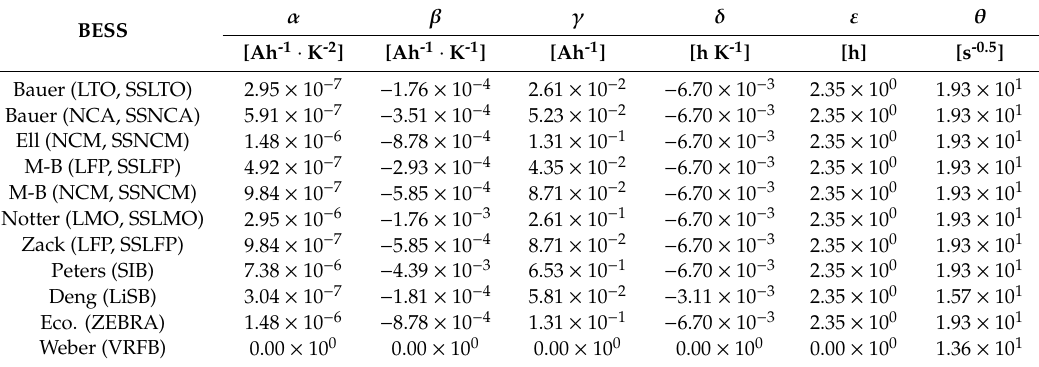
Table 2. Ageing parameters of